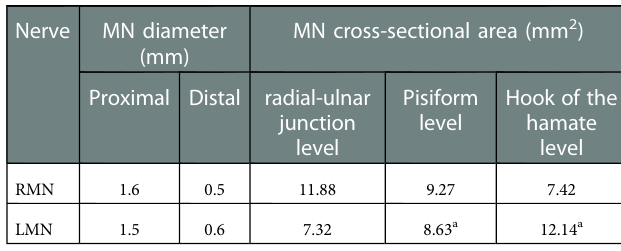
TABLE 1 MN diameter and cross-sectional area in the carpal